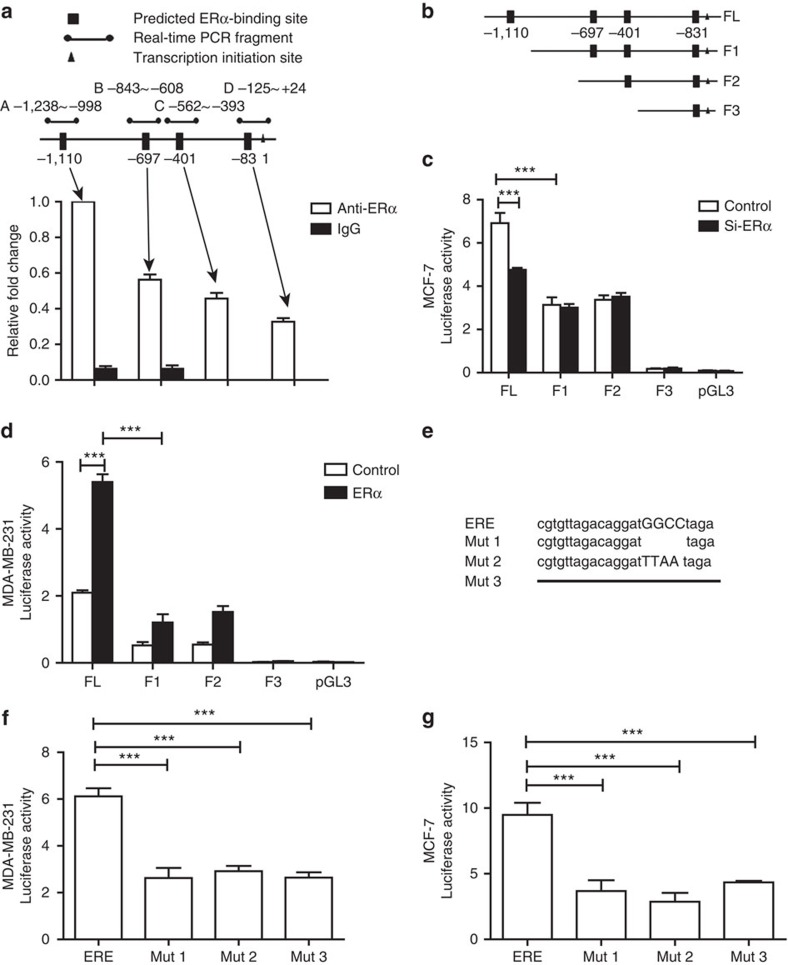
ERα is a transcriptional promoter of vinculin.(a) The schematic diagrams of human vinculin promoter containing four putative ERα-binding sites and the amplification regions of ChIP primers are presented in the top panel. The bottom panel shows the amounts of DNA fragments that were normalized to the total input genomic DNA from MCF-7 cells precipitated by either anti-ERα monoclonal antibody or control IgG (n=3). (b) Schematic diagrams of vinculin promoter truncation. FL indicates the full length of the vinculin promoter, and the corresponding truncation is represented by F1, F2 and F3. (c) Luciferase activity was measured in MCF-7 cells co-transfected with truncated vinculin promoter and ERα siRNA. pGL3-basic plasmid was used as a negative control (n=3). (d) Luciferase activity was measured in MDA-MB-231 cells co-transfected with the truncation of the vinculin promoter and the ERα vector (n=3). (e) Schematic diagrams of a 23-bp ERE in the vinculin promoter and respective mutation. Mut1: deletion of GGCC sequence; Mut2: replacing GGCC with TTAA; Mut3: totally deleting ERE. (f) Luciferase activity was measured in MDA-MB-231 cells transfected with mutations of the vinculin promoter and ERα vector (n=3). (g) Luciferase activity was measured in MCF-7 cells transfected with mutations of the vinculin promoter (n=3). (a,c,d,f,g) The data are shown as the mean±s.e.m. ***P<0.001 (a,c,d,f,g) ANOVA with Dunnett t-test.